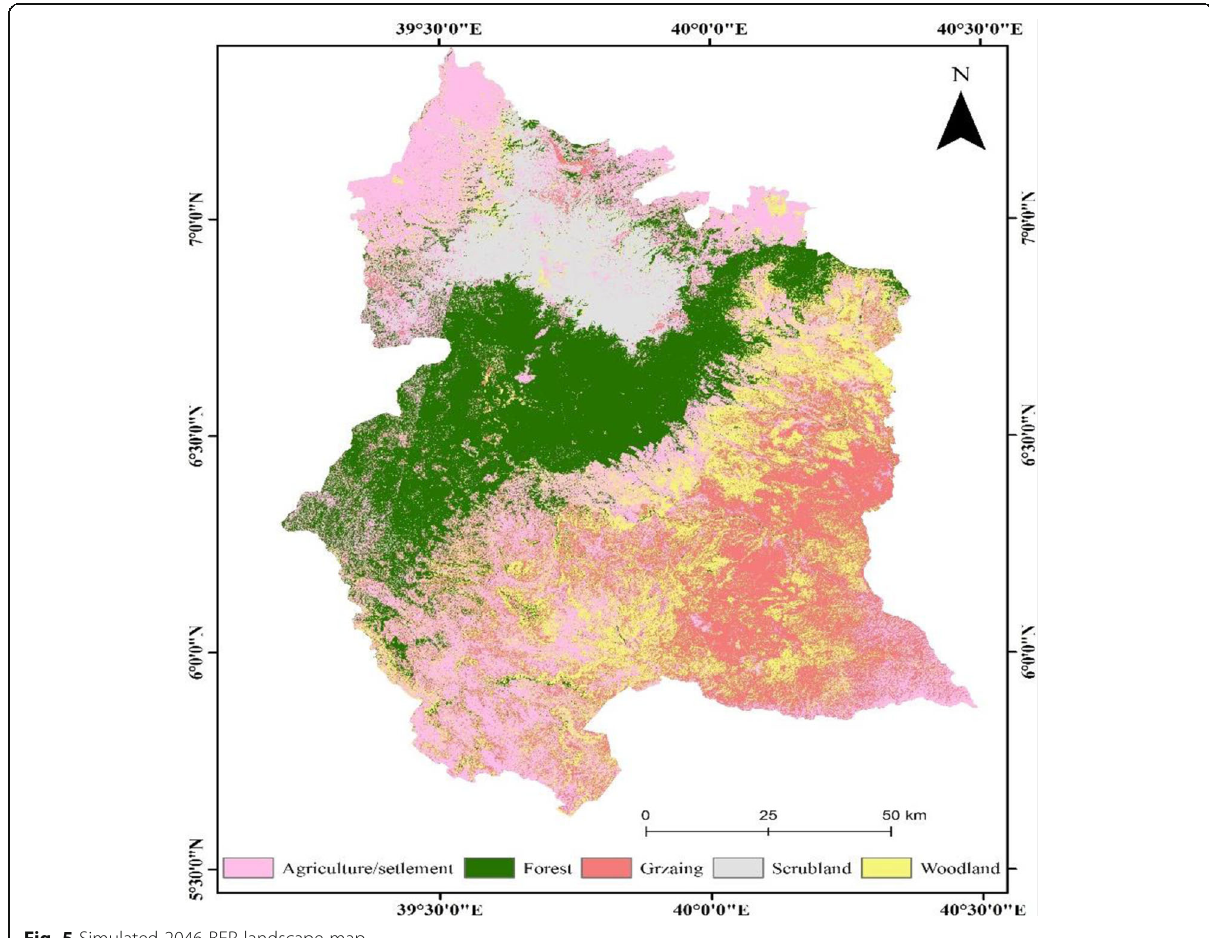
Fig. 5 Simulated 2046 BER landscape